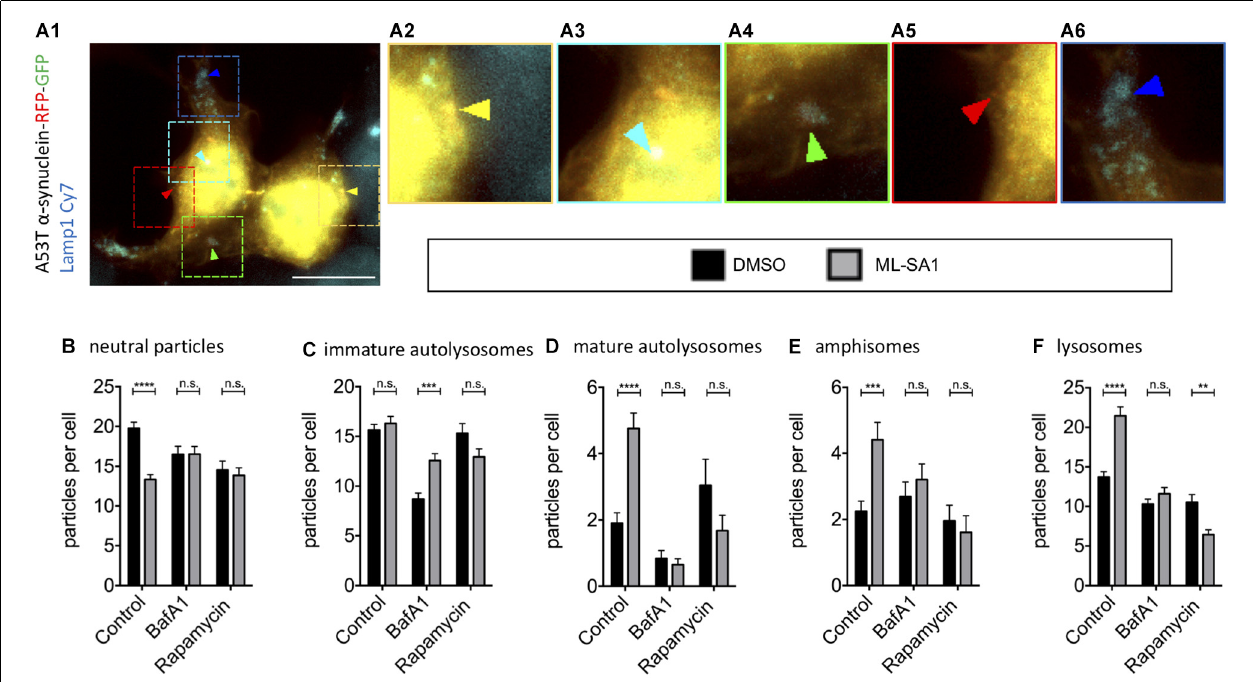
FIGURE 6 | Effect of TRPML1-Agonist ML-SA1 on TFL-tagged A53T- α -synuclein vesicles positive and negative for Lamp1. (A) Example image of HEK293T cells transfected with A53T- α -synuclein tagged mRFP-EGFP tandem-fluorescence (TFL) and treated for 18 h either with 25 µ M ML-SA1 or with DMSO and additionally 5 nM Bafilomycin A1 or100 nM Rapamycin or DMSO. Cells were further stained against the lysosomal marker Lamp1. The scale bar represents 20 µ m. (A1–6) Close-up of 15 × 15 µ m: yellow arrows mark neutral A53T- α -synuclein particles (neutral particles), light blue arrows mark neutral A53T- α -synuclein/Lamp1-positive vesicles (immature autolysosomes), green arrows mark acidic A53T- α -synuclein/Lamp1-positive vesicles (mature autolysosomes), red arrow marks A53T- α -synuclein/Lamp1-negative acidic vesicles (amphisomes) and blue arrows mark vesicles only positive for LAMP1 (lysosomes). (B–F) Abundance and distribution of vesicles from n = 3 independent experiments. Vesicles were discriminated by luminal pH and Lamp1 staining as described in (A) . Two-way-ANOVA (factors ML-SA1 and BafA1/Rapamycin) showed significant interaction for all vesicle types (values in brackets), (B) neutral particles ( p = 0.0001), (C) immature autolysosomes ( p = 0.001), (D) mature autolysosomes ( p < 0.0001), (E) amphisomes ( p = 0.02), (F) lysosomes ( p < 0.0001). Sidak’s multiple coparisons test is depicted with respect to DMSO. **p < 0.01, *** p < 0.001, **** p < 0.0001, non-significant differences are depicted as